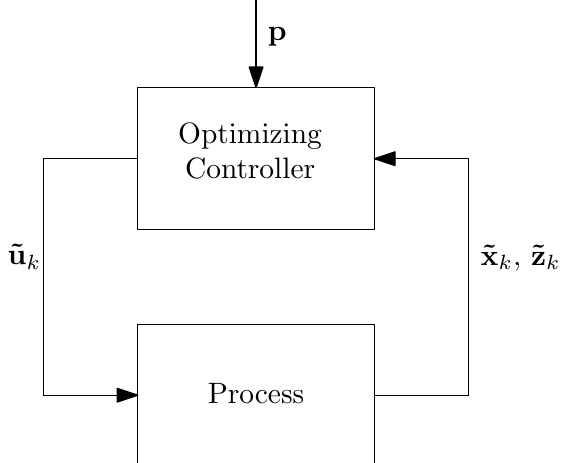
Figure 5. Schematic representation of the optimizing control structure. The Dynamic RTO (Real-time optimization) for nominal, worst case or scenario-based approach computes the optimal gas lift rates for the two wells and sets the process at each